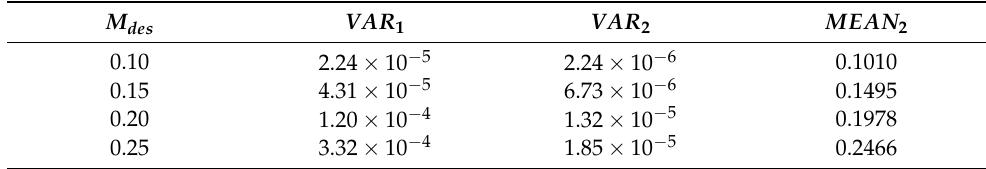
Table 3. The statistical data for the basic image